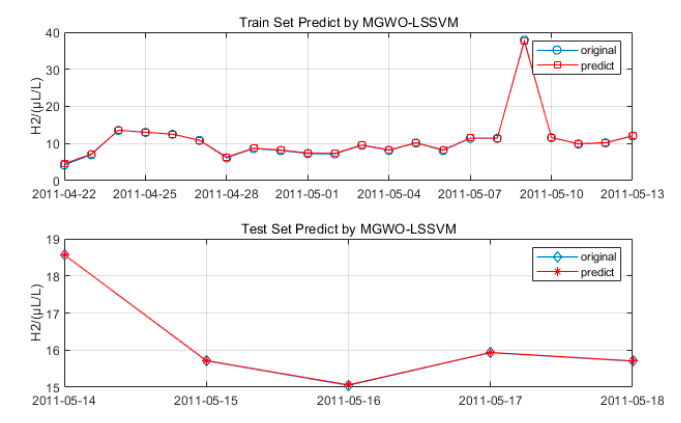
Figure 5. Prediction result of H 2 by the GRA-EMD-MGWO-LSSVM model.